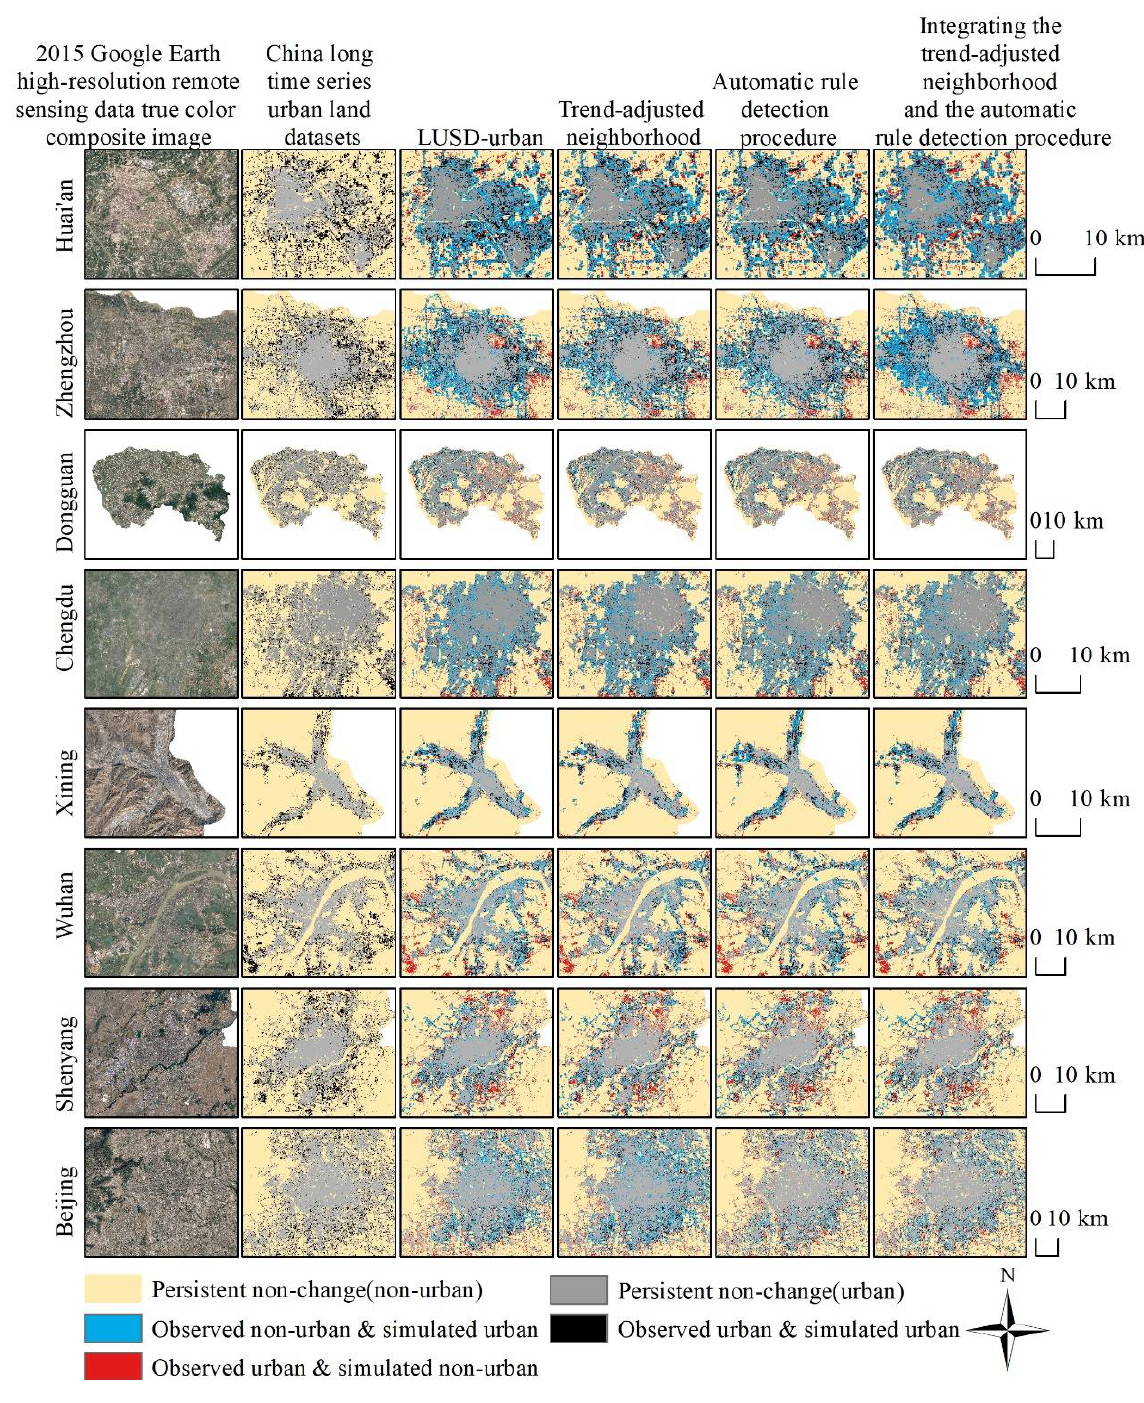
Figure 6. Comparison between the actual growth and the simulated urban expansion during 2010–2015.